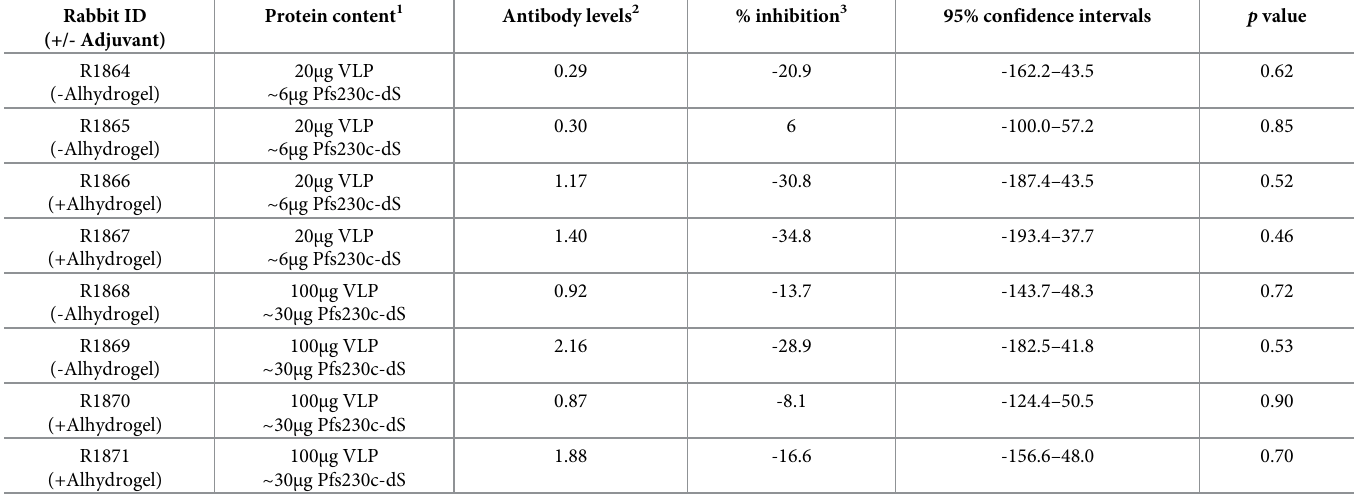
Table 1. Assessment of transmission-blocking activity of rabbit antibodies against Pfs230c-dS/dS VLPs by SMFA. Rabbit ID (+/- Adjuvant)